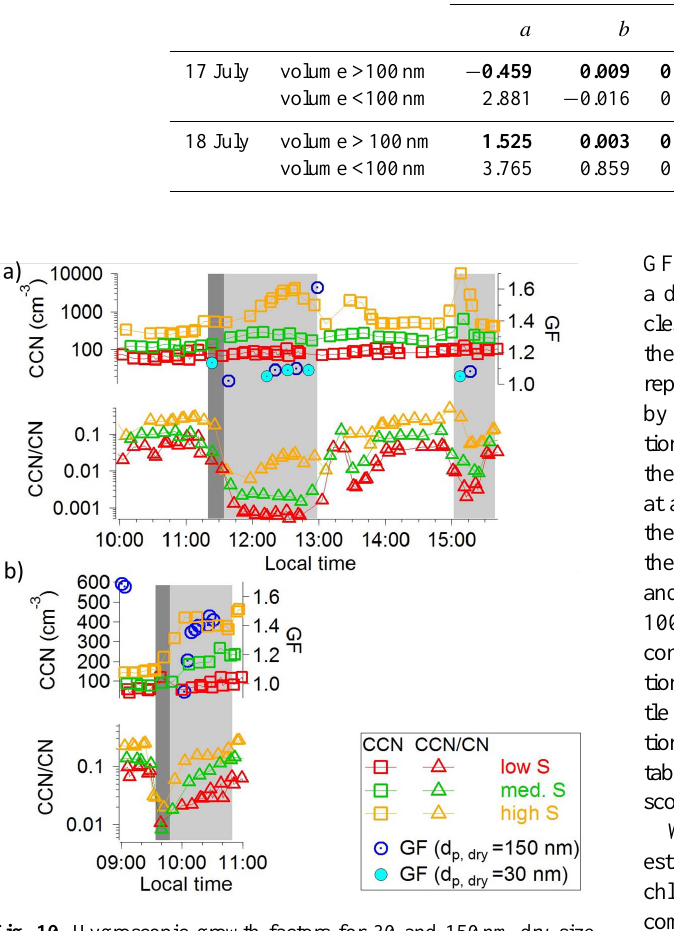
Fig. 10. Hygroscopic growth factors for 30 and 150nm dry size at 92% RH, and time series of CCN concentrations and activa- tion ratios at three supersaturations: 0 . 07 < S < 0 . 08% (red, low), 0 . 24 < S < 0 . 26% (green, medium), and 0 . 87 < S < 0 . 88% (yel- low, high) for the plume sampling events on 17 July (a) and 18 July (b) . Dark-gray shading represents plume age A1, and light- gray shading plume ages A2 and A3. Refer to Sect. 3.4 for more